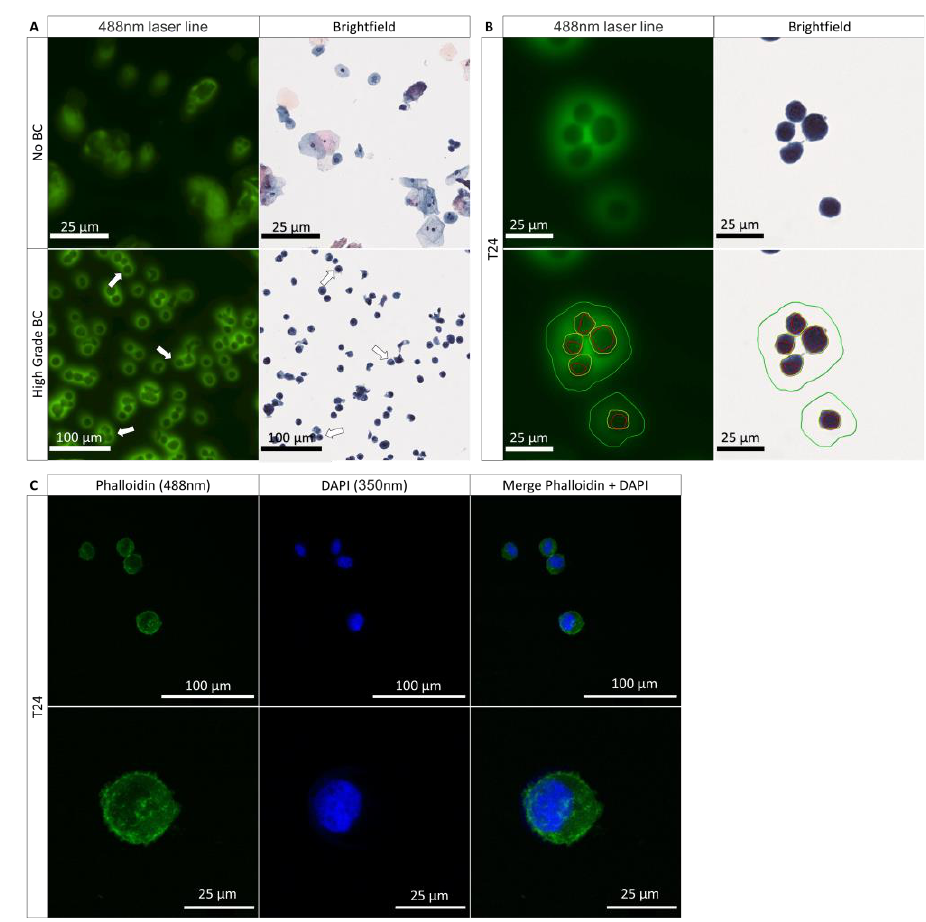
Figure 1. Characteristics of the fluorescence from healthy and tumoral urothelial cells. ( A ) Urinary cytology acquired on the scanner of a healthy patient (no BC) and a patient with an HGBC (high- grade BC) in bright field light and at 488 nm; arrows show the tumor cells expressing a PMF. ( B ) Scanning images of T24 cells from a cell culture with a demarcation of the nuclear membrane in red, the plasma membrane in yellow, and the PMF, in green in bright field light and at 488 nm. ( C ) Immunofluorescence labeling of the cytoplasm with phalloidin (488 nm) and of the cell nucleus with DAPI (350 nm) to determine the presence of an eclipse